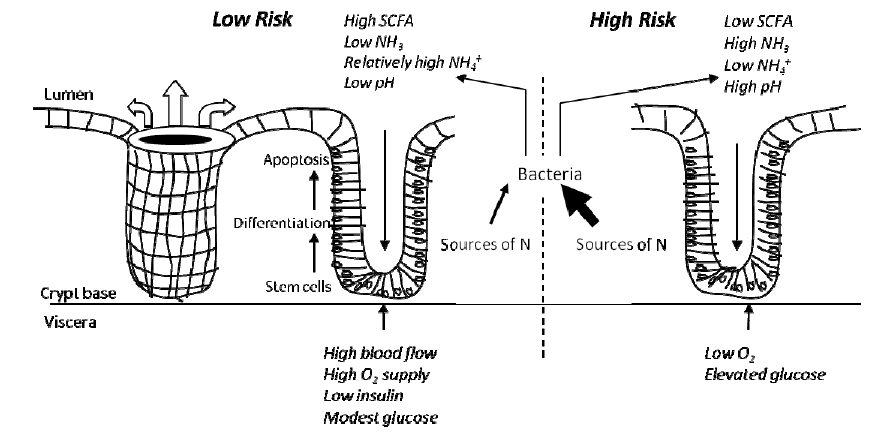
Figure 1. Low risk versus high risk colonic environment. A low risk colonic environment is characterised by well perfused mucosa and relatively high luminal concentration of SCFA, low levels of ammonia, and has low pH. In this low risk environment, mucosal cells utilise butyrate as the primary energy source and have low requirement for glucose. Conversely, a high risk environment is higher in pH and ammonia and low in SCFA. Mucosal cells adapt to these conditions, and acquire epigenetic and genetic changes to survive, predisposing to